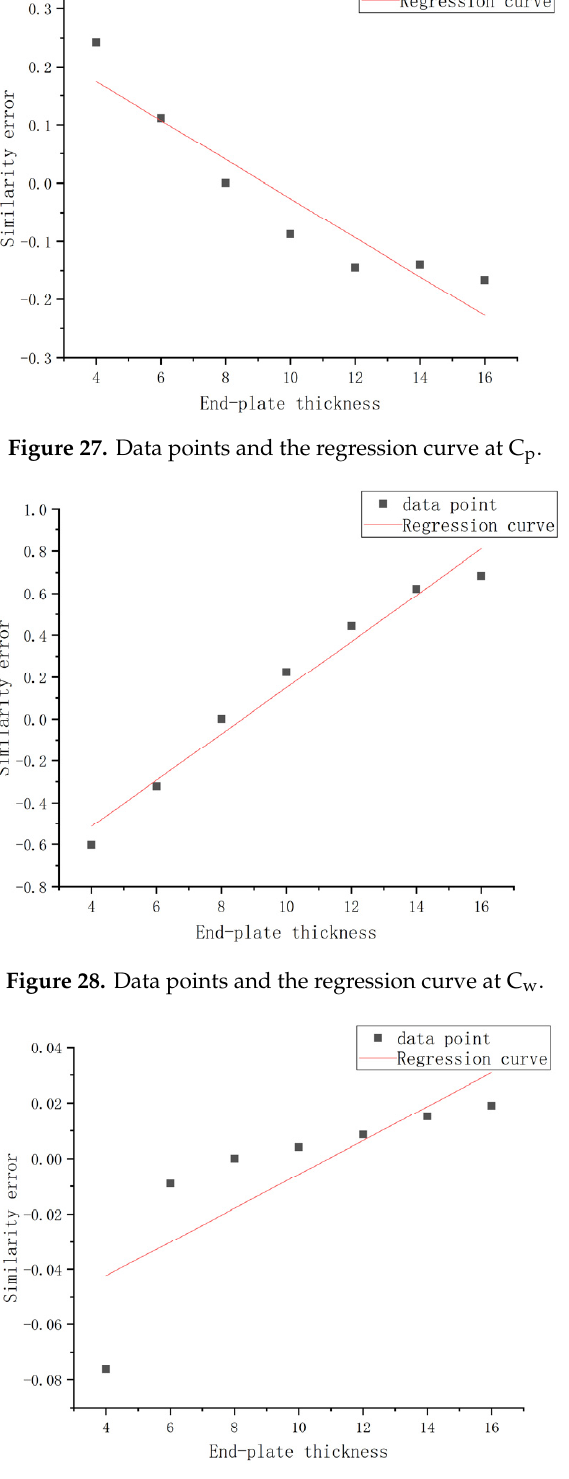
Figure 29. Data points and the regression curve at N c